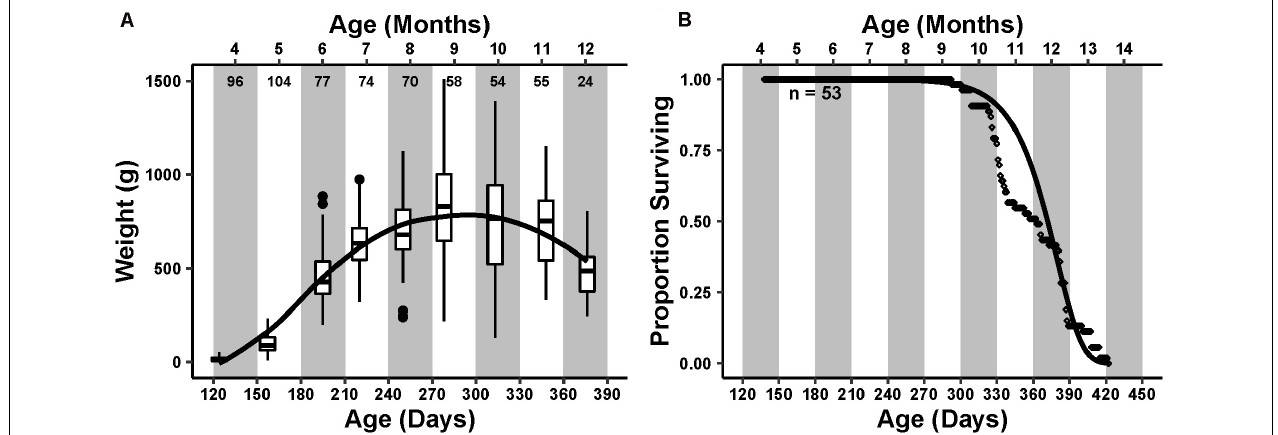
FIGURE 1 | Cohort life history. Primary x -axis is the time in days post hatch, with the secondary x -axis at the top representing the age in months that is further emphasized by the alternating white and gray bars in the plot area. (A) Cohort weight trend. Box and whisker plots represent the interquartile range and median of weight measured at each monthly sampling point. Small numbers below the secondary axis are the number of individuals weighed that month. The curve drawn over the boxplots represents a loess smoothing of the data, showing an increasing and then decreasing weight trend peaking at age 9–10 months. (B) Survivorship of 53 individuals. Each point is the daily proportion of animals surviving. A Gompertz survival function, s = exp [ ( A G )( 1 − e Gt ) ] , was fit to the survivorship data visualized as a curve over the points. Initial mortality rate (A) and actuarial aging rate (G) were 7.4 × 10 − 10 and 0.047,